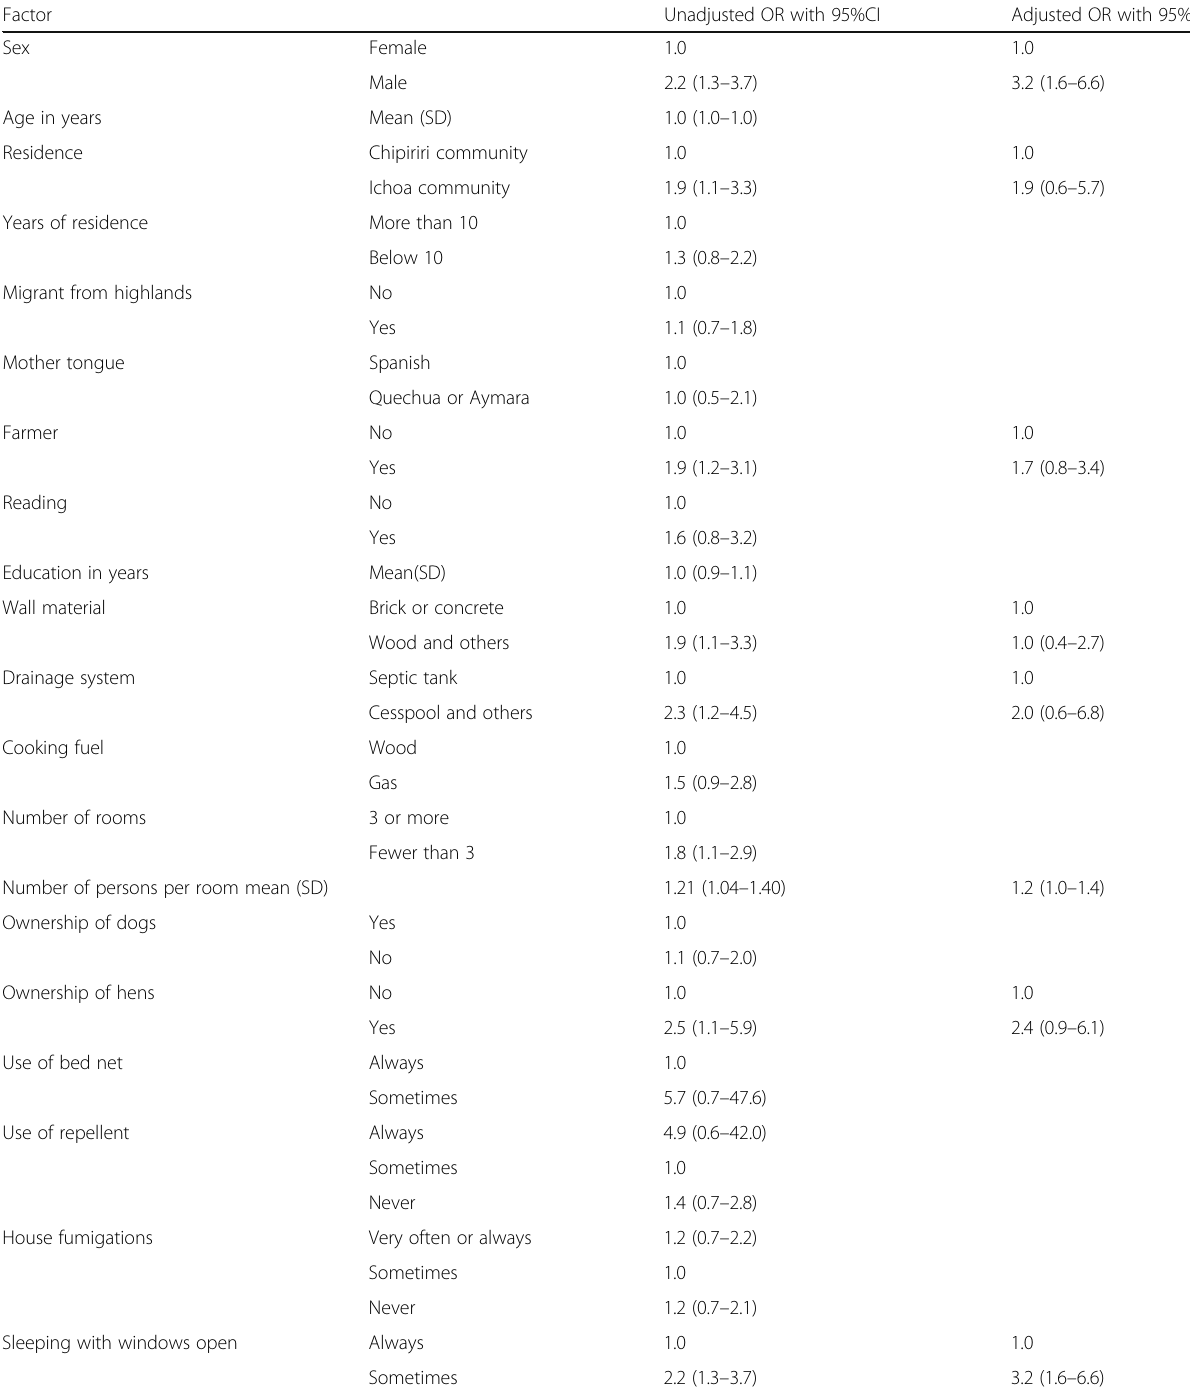
Table 4 Univariate and multivariate analysis of sociodemographic, housing conditions, and protective activities associated with